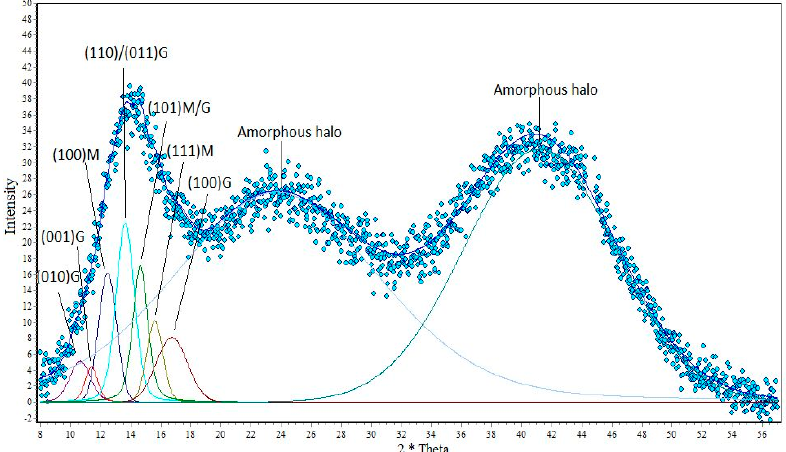
Figure 2. Distribution of the diffraction curve of calcium alginate fibers without nano additive.